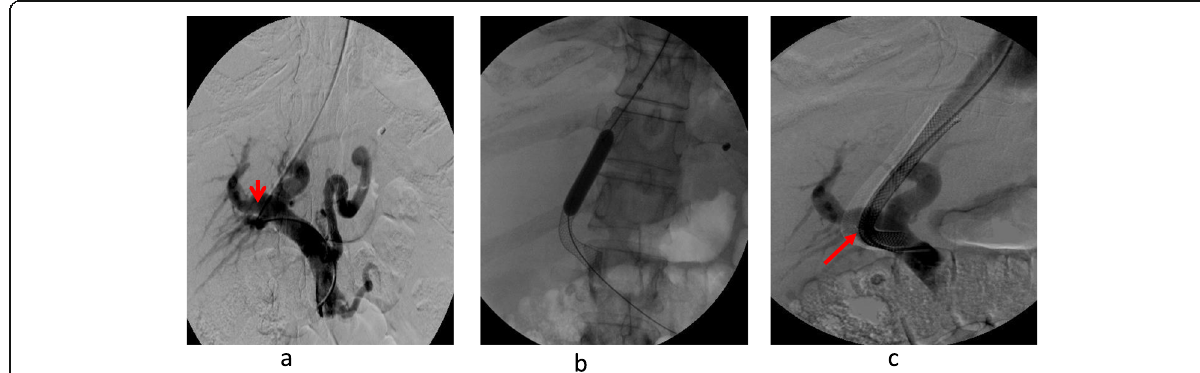
Fig. 7 Standard TIPS in a patient of the TIPS-RPV group. The right portal vein (arrowhead) was approached followed by the main portography to measure the pressure ( a ). Finally, the Wallstent that was delivered shows inevitable angulation (arrow) through the course between the right portal and cava ( b , c